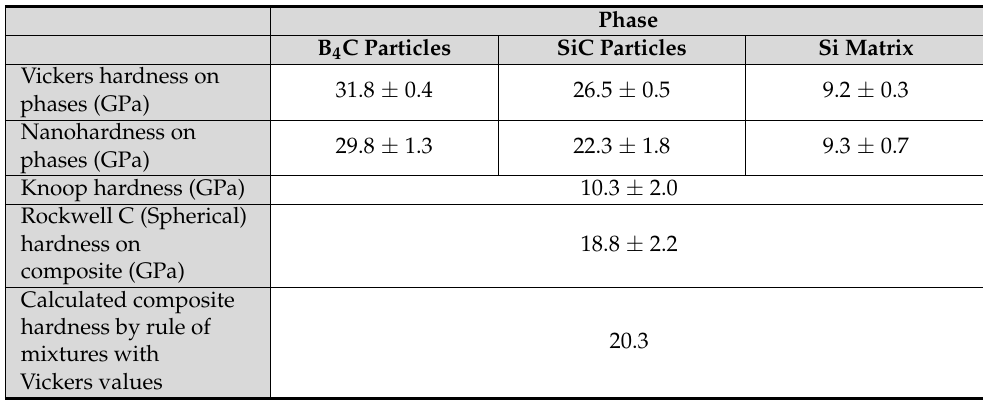
Figure 6. Optical image of the SiC-B 4 C-Si composite sample showing examples of Vickers microhard- ness indentations on composite samples performed on a preform infiltrated with only Si in ( A ) the Si matrix, ( B ) within a SiC particle, and ( C ) within a B 4 C particle. Table 3. Hardness values of matrix and reinforcement performed with Vickers hardness indentation, nanoindentation, Knoop indentation, and spherical